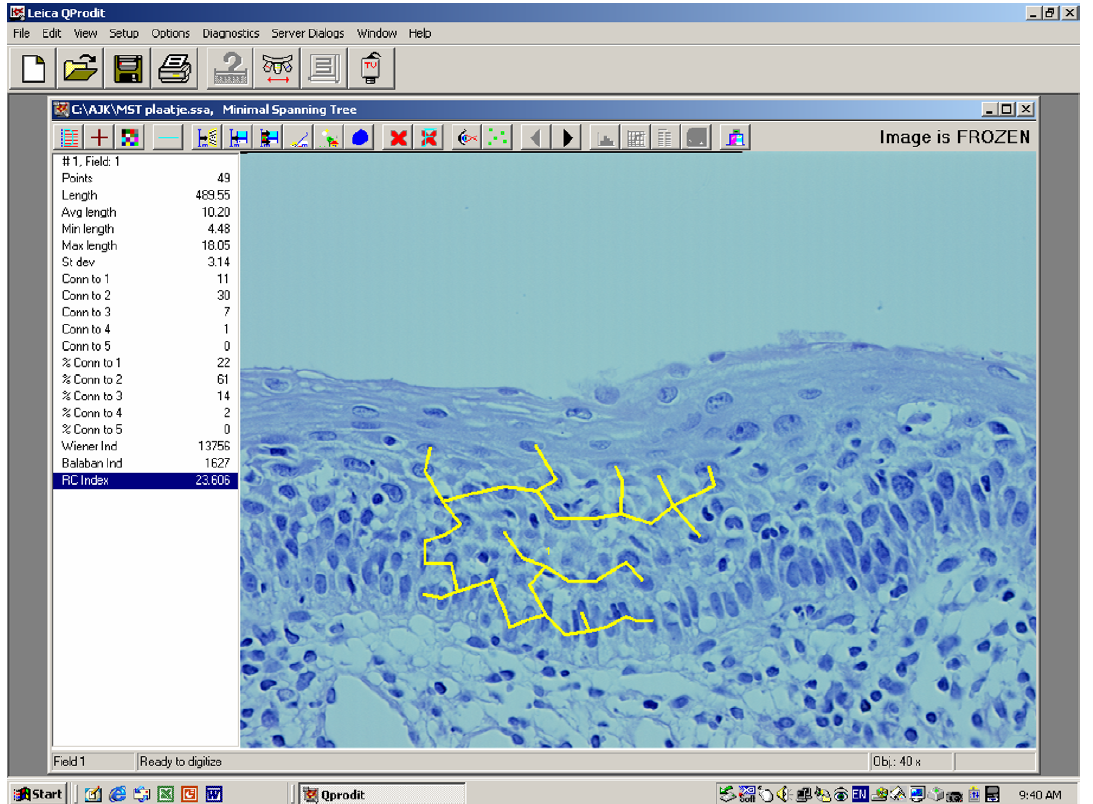
Fig. 2. Illustration of the image analysis method. In each case the most severely dysplastic part of the epithelium in the H&E section used for the routinely assessed diagnosis was selected. In this area, the upper border, the basal membrane, and the borders between the two deepest layers of the epithelium were marked (the deepest layer excluding the basal cell layer). SSA was performed in fields of vision chosen randomly in the already demarcated area by constructing a Voronoi diagram (VD) and a minimum spanning tree (MST) per field. Briefly, with an × 40 objective (final magnification × 1200) the centres of gravity of all nuclei in the lower deep half of the epithelium per field of vision were interactively marked on a video screen by setting a point with the cursor of the system. Using this set of points, the computer program composed the VD and the MST. The Voronoi tessellation splits the image plane into polygons, each containing one nuclear centre of gravity in its centre and in such a way that each point in the polygon was closer to this centre nucleus than to any other point in the plane. The MST interconnected a set of nuclei in such a way that the total length of the lines was minimal and no loops were formed. The quantitative image analysis system automatically calculated a large number of quantitative features for each case. The values per case were the total of the measurements in the five fields taken together and for each of the features, the mean and standard deviation (SD) of the five fields analysed were calculated per